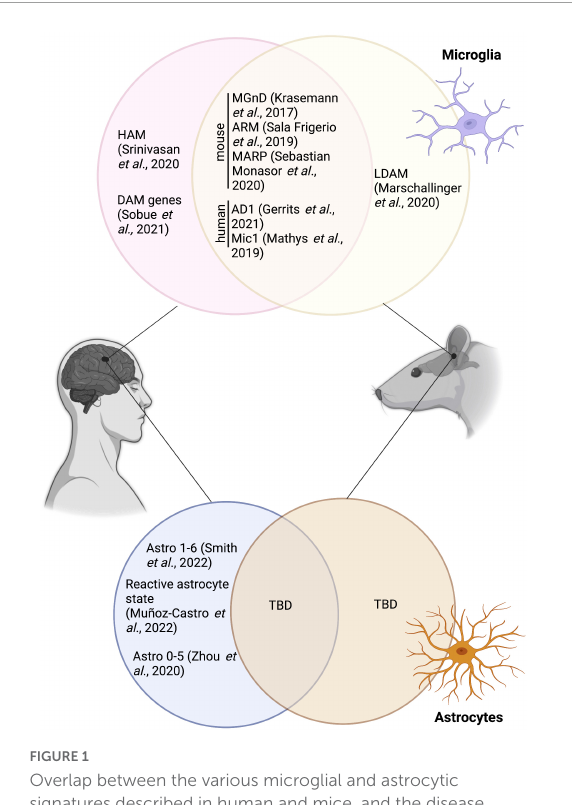
FIGURE1 Overlap between the various microglial and astrocytic signatures described in human and mice, and the disease associated microglia and disease-associated astrocytes. HAM, human AD microglia; MGnD, neurodegenerative disease phenotype; ARM, activated-response microglia; MARP, microglial Aß response proteins; AD1, Alzheimer’s disease 1; LDAM, lipid droplet-accumulating microglia; TBD, to be determined. Figure was created using